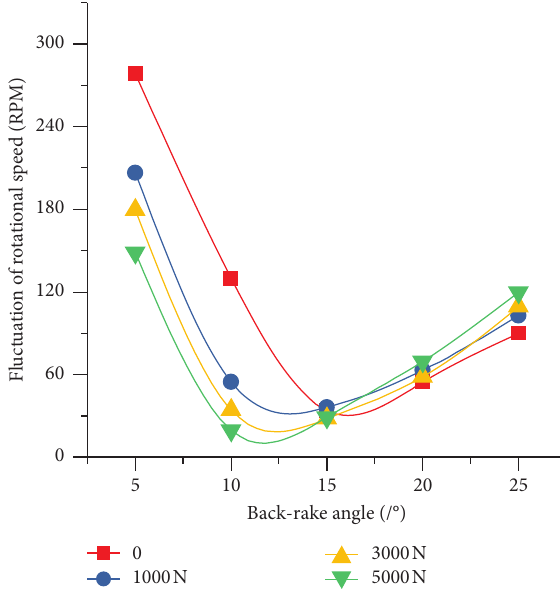
Figure 7: Experimental results of torsional stability of drillstring.